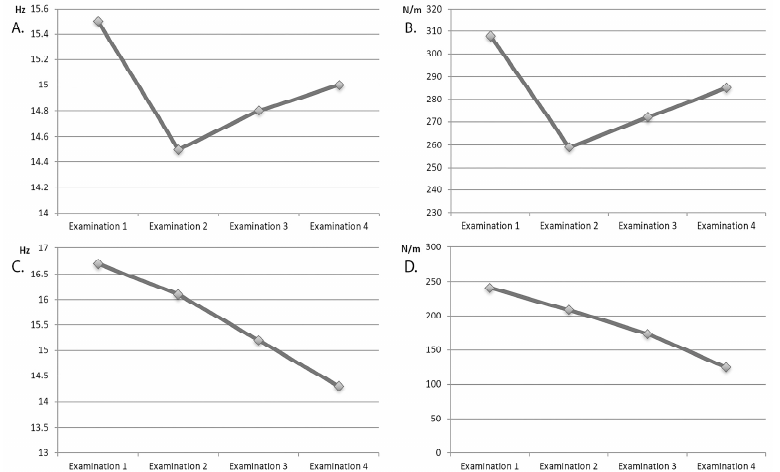
Figure 3. The direction of characteristic changes in muscle tone of selected muscles of the upper extremity and trunk in a standing position during examinations I to IV. ( A ). Oscillation frequency of flexor digitorum superficialis. ( B ). Stiffness of flexor digitorum superficialis. ( C ). Oscillation frequency of latissimus dorsi. ( D ). Stiffness of latissimus dorsi.